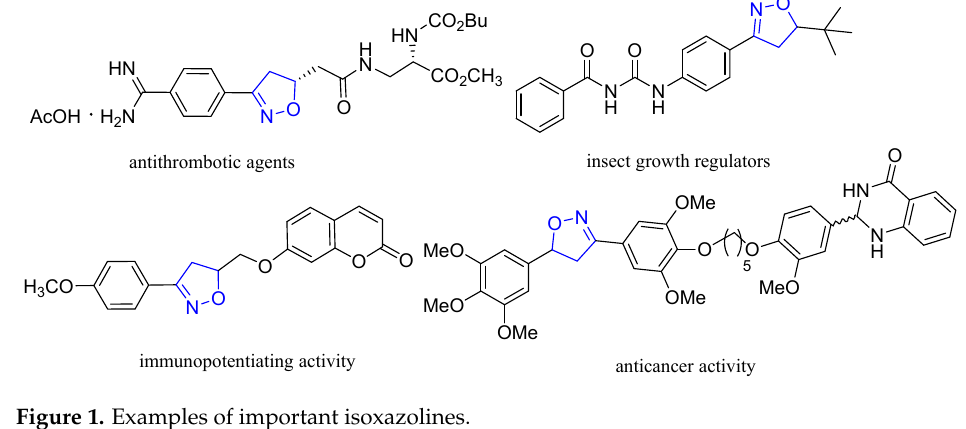
Figure 1. Examples of important isoxazolines.